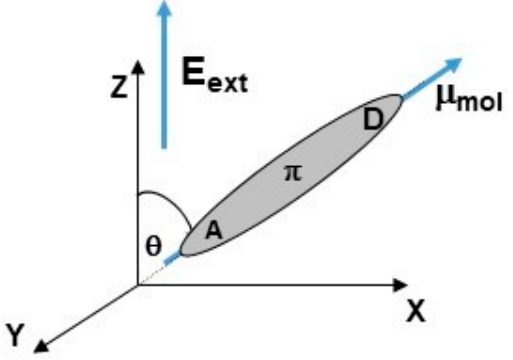
Figure 1. The location of the θ angle defines the position between the direction of the external elec- electric field (E ext ) and the electric dipole moment ( µ mol ) of a chromophore molecule. The molecule tric field (E ext ) and the electric dipole moment ( μ mol ) of a chromophore molecule. The molecule is is presented in a laboratory coordinate presented in a laboratory coordinate system.